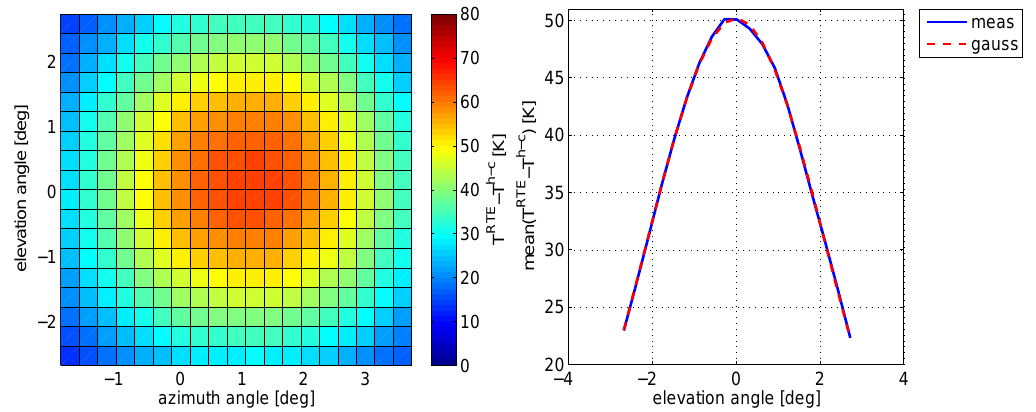
Fig. 10. Calibration of the elevation and azimuth pointing of MIAWARA-C using the Sun scanning method. Left panel: Result of Sun scanning interpolated to rectangular coordinate system relative to the Sun. Right panel: Gaussian curve fitted to weighted mean value of the